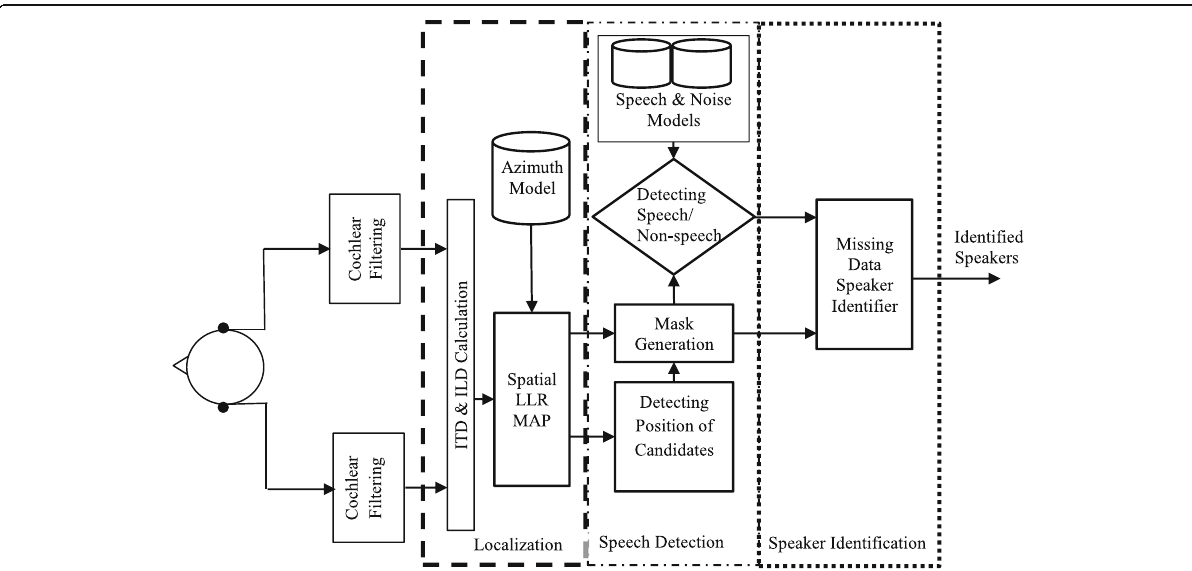
Fig. 2 The block diagram of May e t al. ’ s binaural scene analyzer [39]. The system is divided into three main stages: binaural localization,